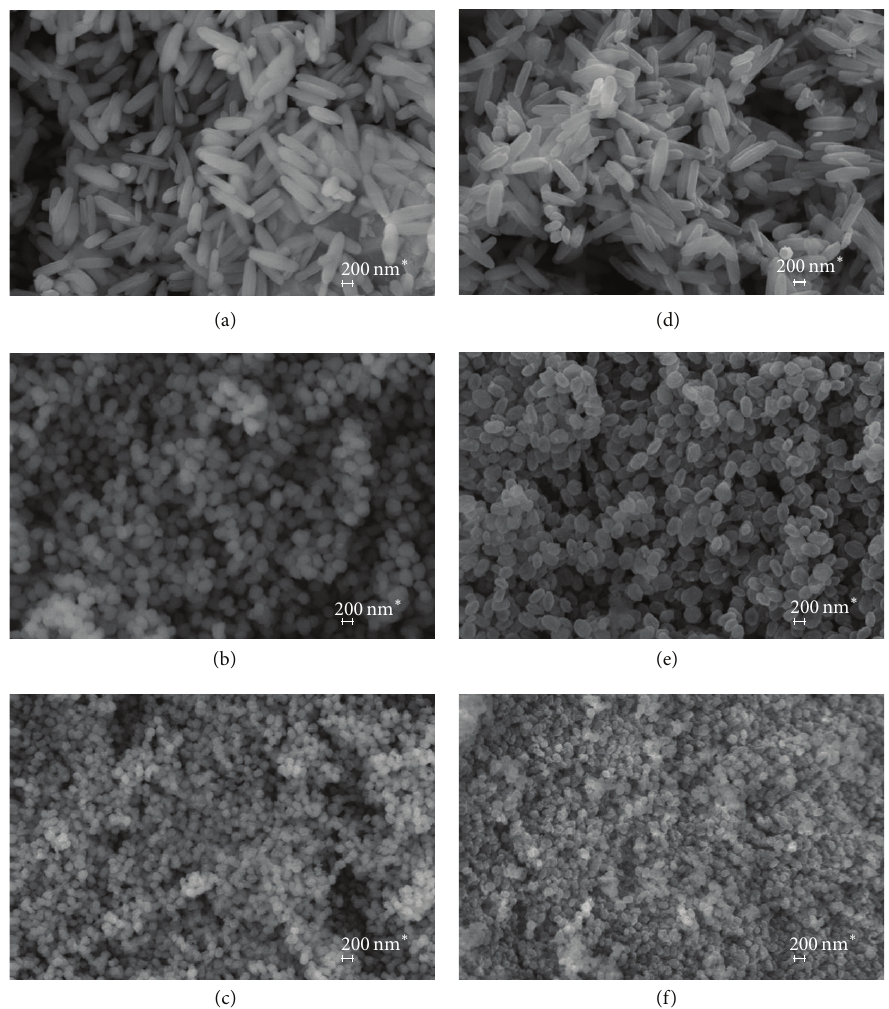
Figure 2: SEM images of GaO(OH) crystals precipitated from GaCl 3 solution with (a) decomposition of urea, (b) NH 4 OH, and (c) NaOH; SEM images of Ga 2 O 3 crystals after thermal conversion of (d) urea precipitated, (e) NH 4 OH precipitated, and (f) NaOH precipitated GaO(OH)